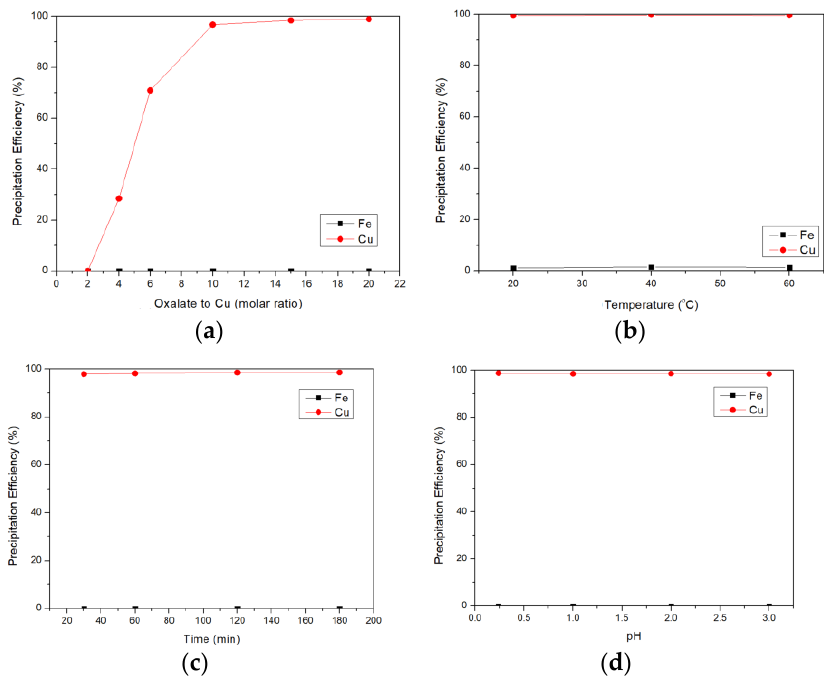
Figure 8. Effects of ( a ) oxalate to Cu molar ratio, ( b ) temperature, ( c ) time, and ( d ) pH on the Cu precipitation.